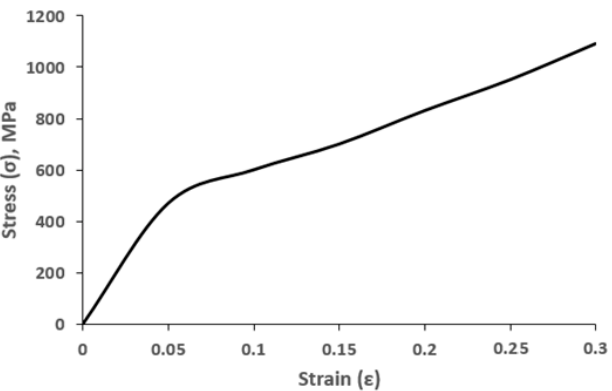
Figure 1. Tensile stress-strain ( σ − ε ) curve for Hadfield steel, deformed by tension at 0.2 × 10 − 3 s − 1 . Upon deformation of Hadfield steel at the constant tensile rate of 0.2 · 10 − 3 s − 1 , there are two stages of plastic flow development II 1 and II 2 with different strain hardening coefficients ( Θ (II 1 ) = 3 · 10 3 MPa and Θ (II 2 )= 2.1 · 10 3 MPa, respectively). The inflection on the σ − ε curve corresponds to the value of the degree of tensile deformation ε = 0.05 (5%) and, presumably, corresponds to the moment of inclusion in the twinning